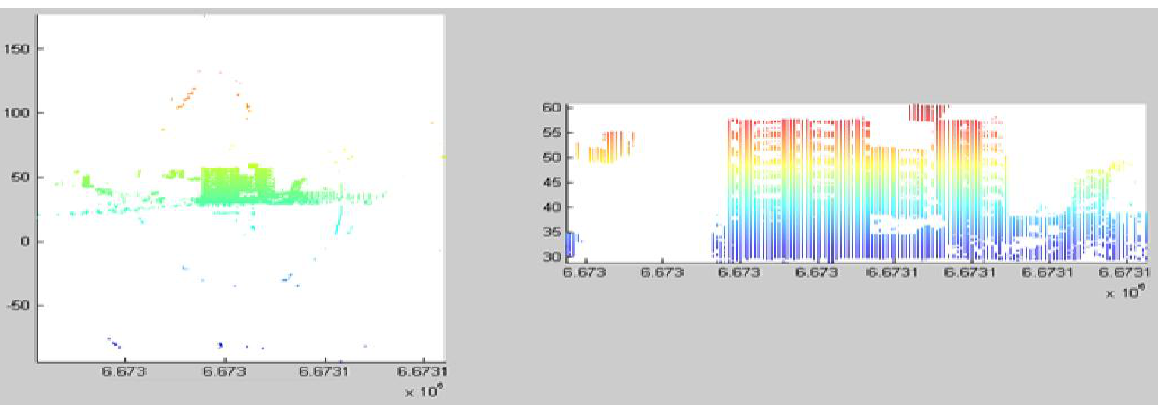
Figure 5. An example of noise point filtering (YZ projection view). Left : Original data Right : Data after noise point removal. The figures are plotted in the same scale with the colors according to the height value of the